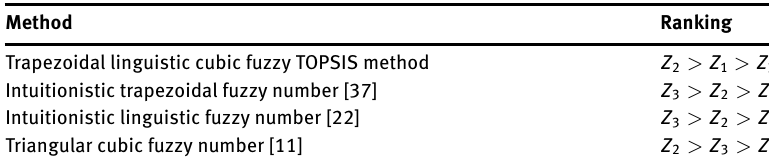
Table 14: The Ranking Values of the Discussed Methods.